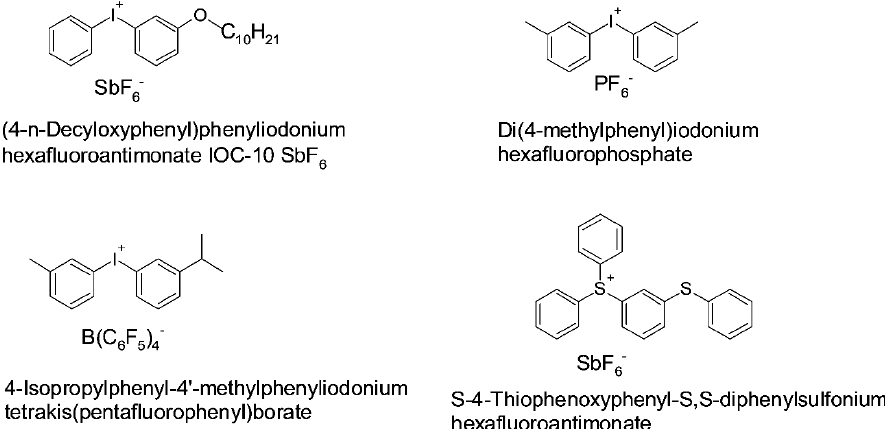
Figure 16. Structure of selected cationic photoinitiators. Reproduced with permission from [186]. Copyright © 2006 John Wiley and Sons.